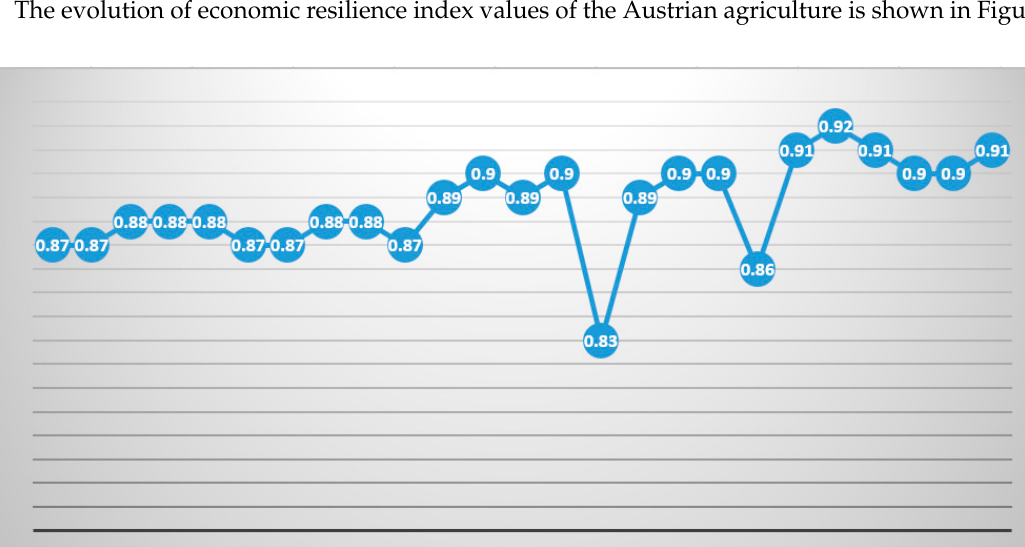
Figure 1. Values of agricultural sector’s economic resilience index from 1995 to 2019, Austria. Source: own work.